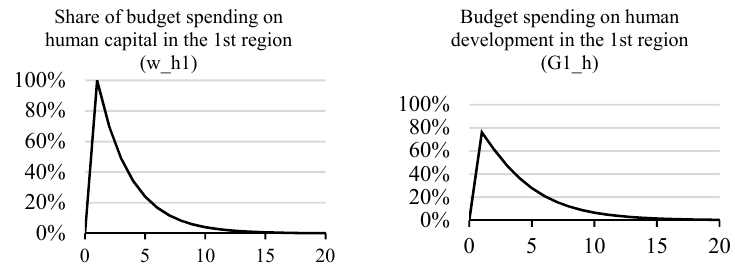
Figure 1. Growth of the share of budget spending on human capital in the first region and the total budget spending on human capital.